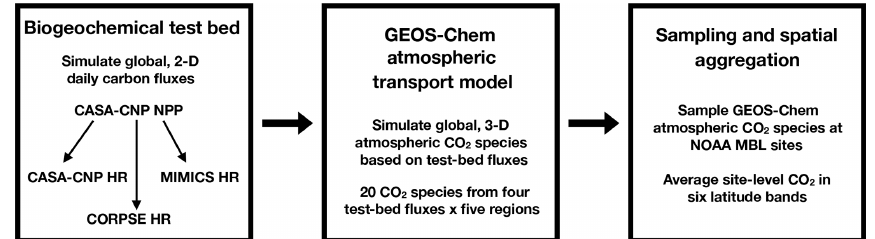
Figure 1. Flow chart depiction of the analysis process from soil model fluxes to simulated CO 2 concentration and comparison with NOAA observations.